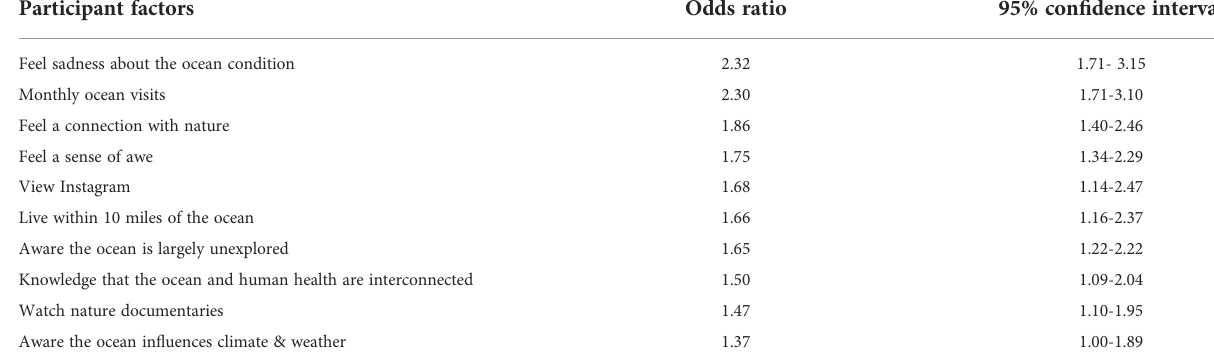
TABLE 3 Association of participant factors with ocean conservation action using multivariable analysis. Participant